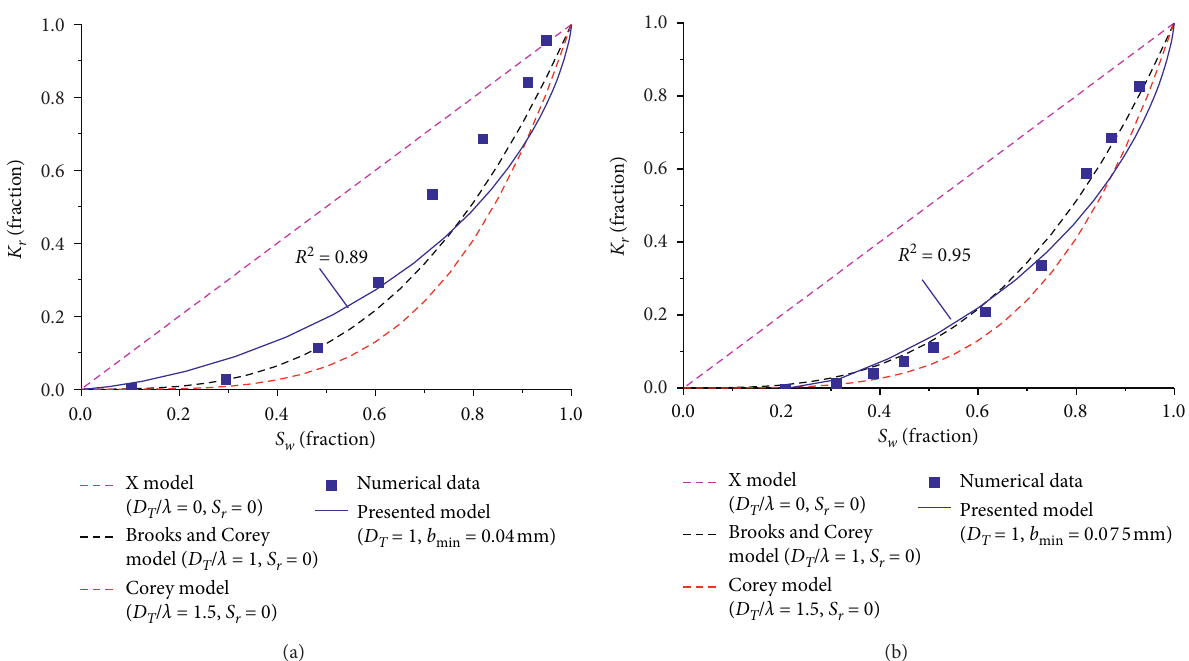
Figure 6: Comparisons of relative permeabilities between the present model and measured data for two fractures of the same lognormal aperture distribution with the mean value and standard deviation of 0.0818 mm and 0.0043mm, respectively: (a) isotropic spatial correlation and (b) anisotropic spatial correlation.